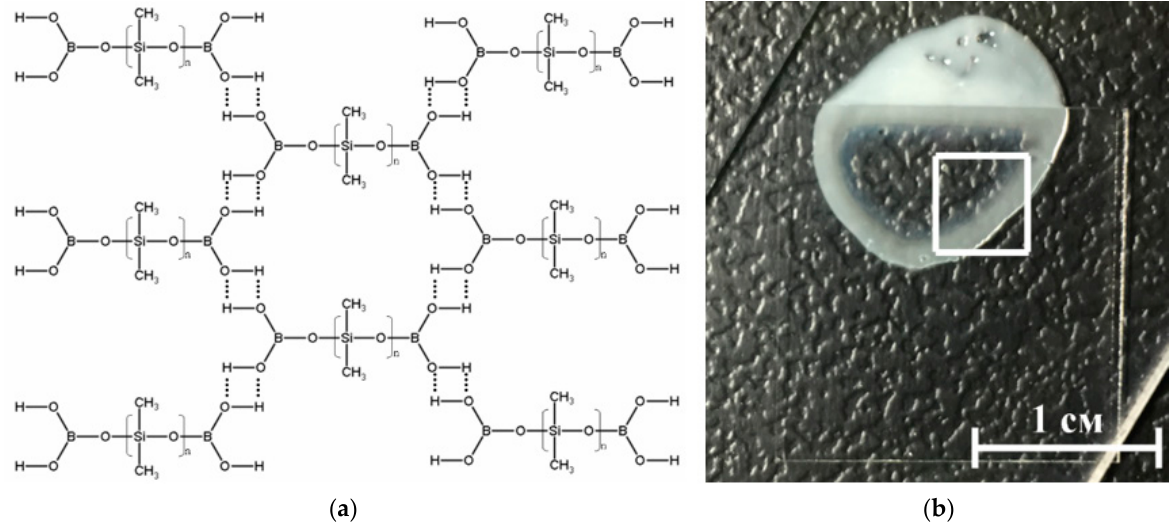
Figure 5. ( a ) Schematic representation of the structure of the BS. BS molecules linked through hydrogen bonds; ( b ) Photo BS-VT, where part of the sample is under the cover glass.